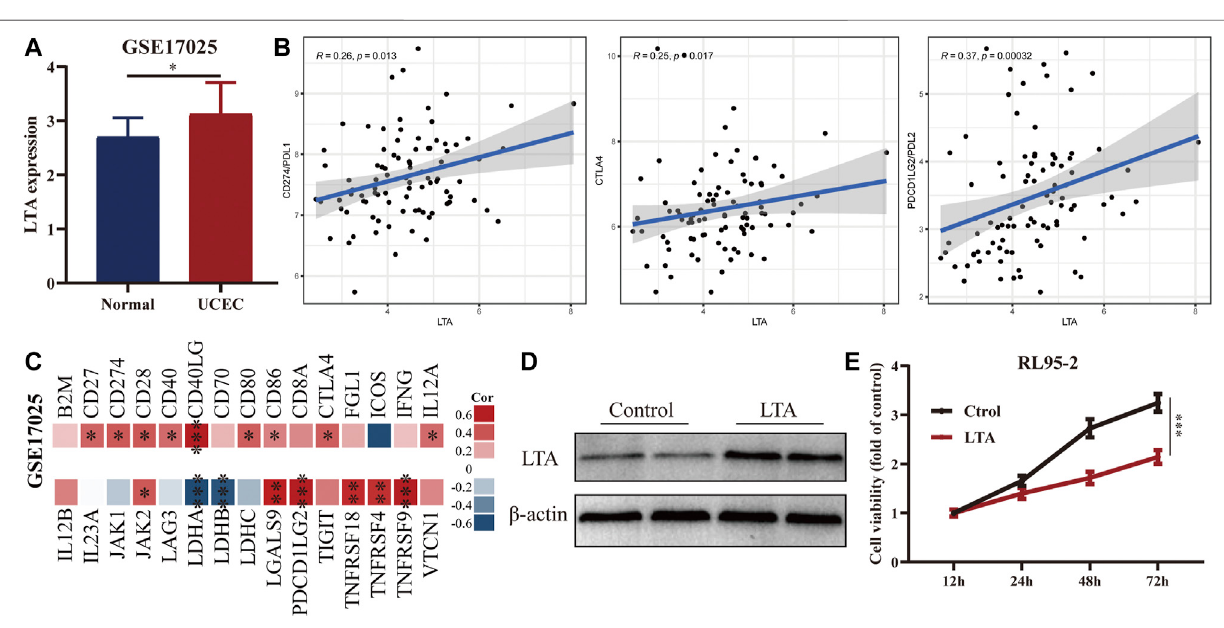
Frontiers in Cell and Developmental Biology |